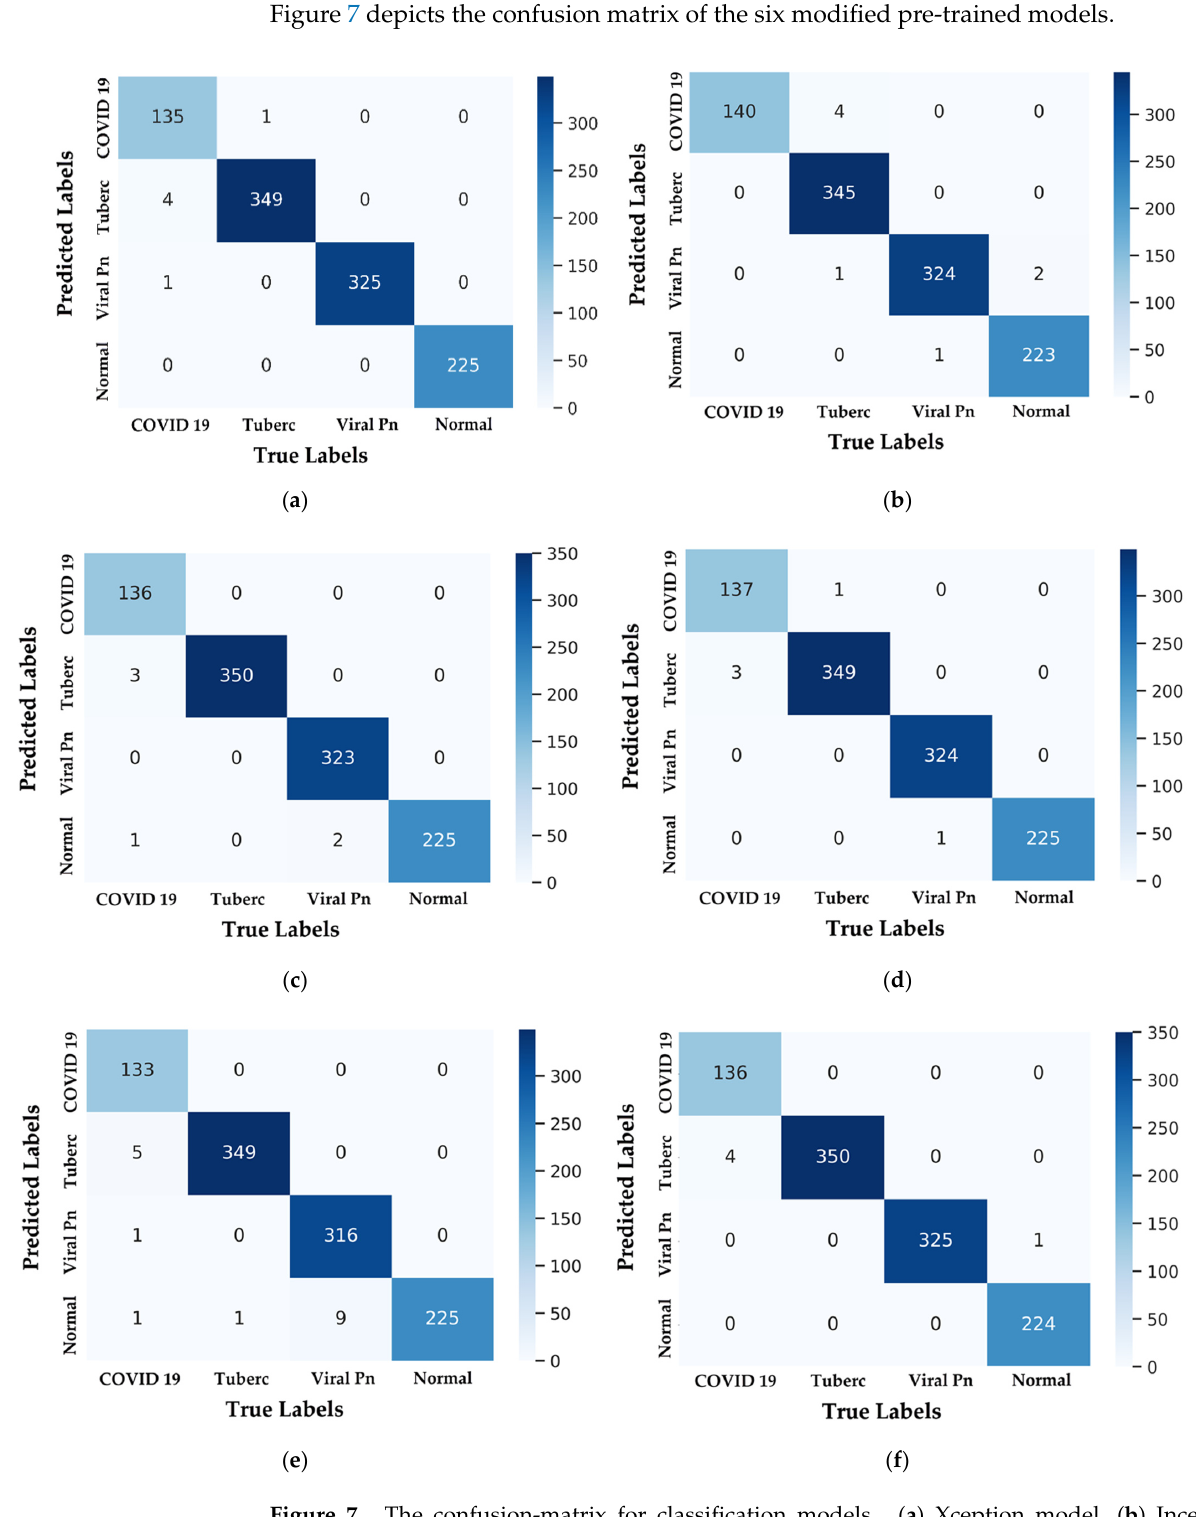
Figure 7. The confusion-matrix for classification models. ( a ) Xception model, ( b ) Inception V3 model, ( c ) InceptionResNet V2 model, ( d ) ResNet50 V2 model, ( e ) MobileNet V2 model, ( f ) DenseNet201